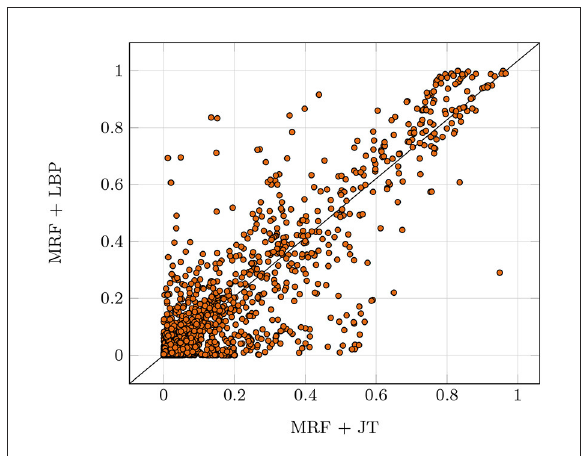
FIGURE6 Deviations of LBP marginals compared to the true marginals computed with the exact JT algorithm over five runs. We used a random Erdos-Renyi-Graph with 20 nodes and an edge probability of 0.25. Each dot represents a single marginal probability, with all marginals ideally being located on the diagonal (LBP marginal equal to JT